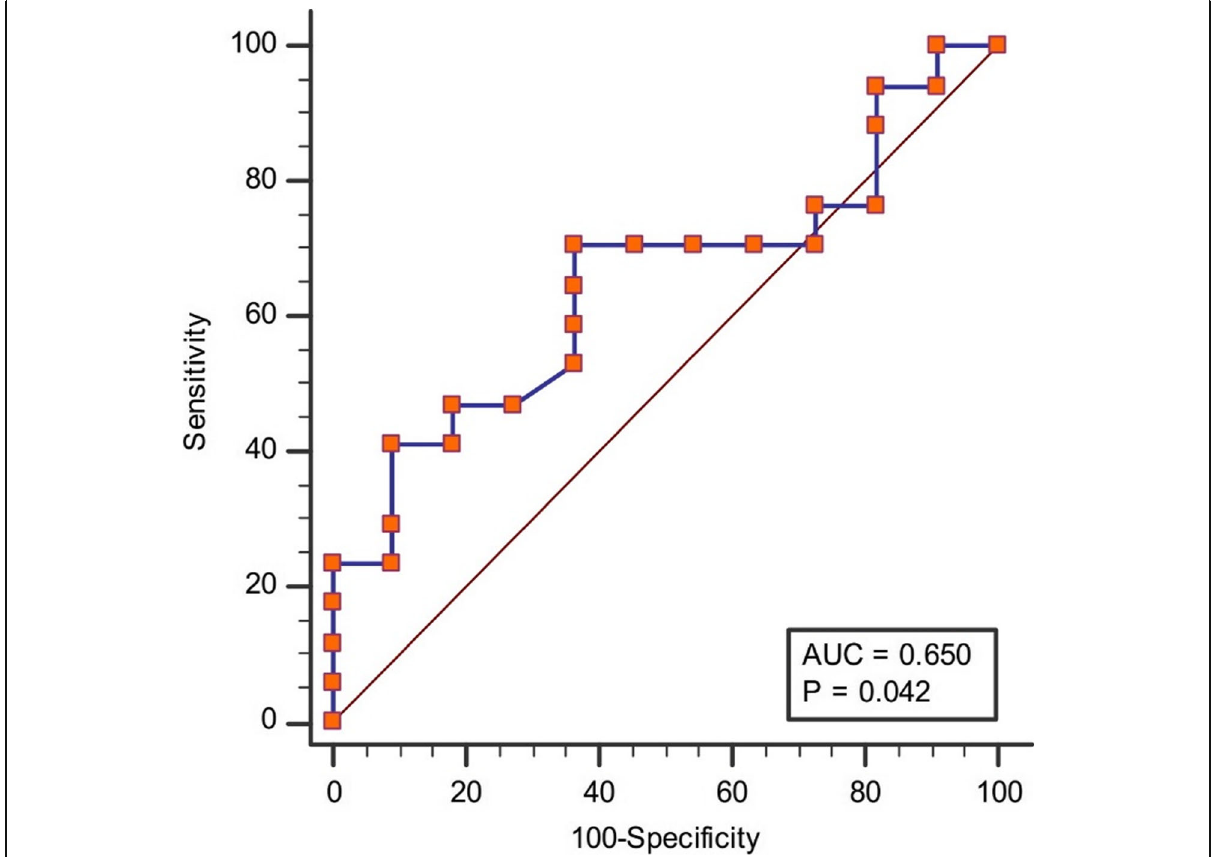
Fig. 1 Initial AMC cut-off point: receiver operating characteristic curve (ROC) for initial AMC (absolute monocyte count) level for survival analysis, AMC at cutoff > 4 × 10 9 /L had an AUC of 0.65 (95% CI 0.511 to 0.772) with a sensitivity of 70.59% (95% CI 52.5 – 84.9%) and a specificity of 63.64% (95% CI 40.7 – 82.8%), P =